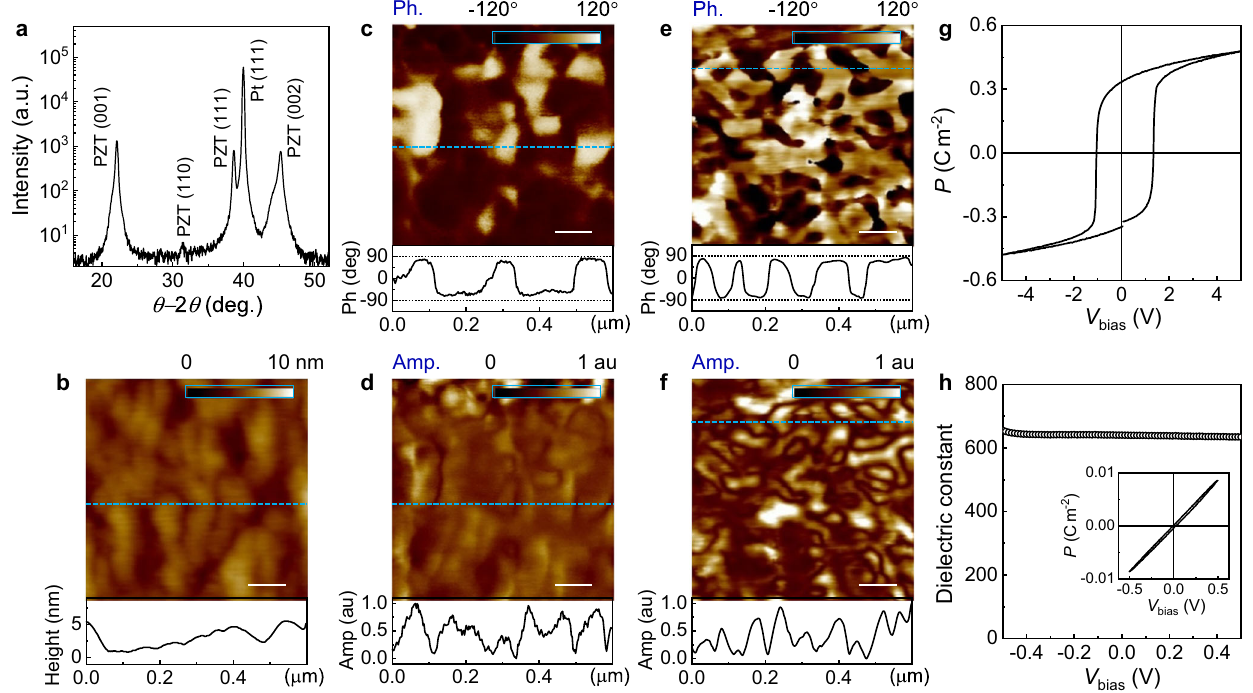
Fig. 1 Characterization of polycrystalline PZT fi lms. a X-ray θ -2 θ scan taken on a 300 nm PZT fi lm. b AFM topography, and c – f PFM images of the same area on a PZT fi lm. c V-PFM phase and d amplitude images. e L-PFM phase and f amplitude images. The lower panels show the signal pro fi les along the dashed lines. Scale bars in b – f represent 100 nm. g P vs . V bias hysteresis taken on a PZT fi lm. h Dielectric constant of the fi lm vs . V bias , with V bias well below the coercive voltage. Inset: P vs . V bias taken at this voltage